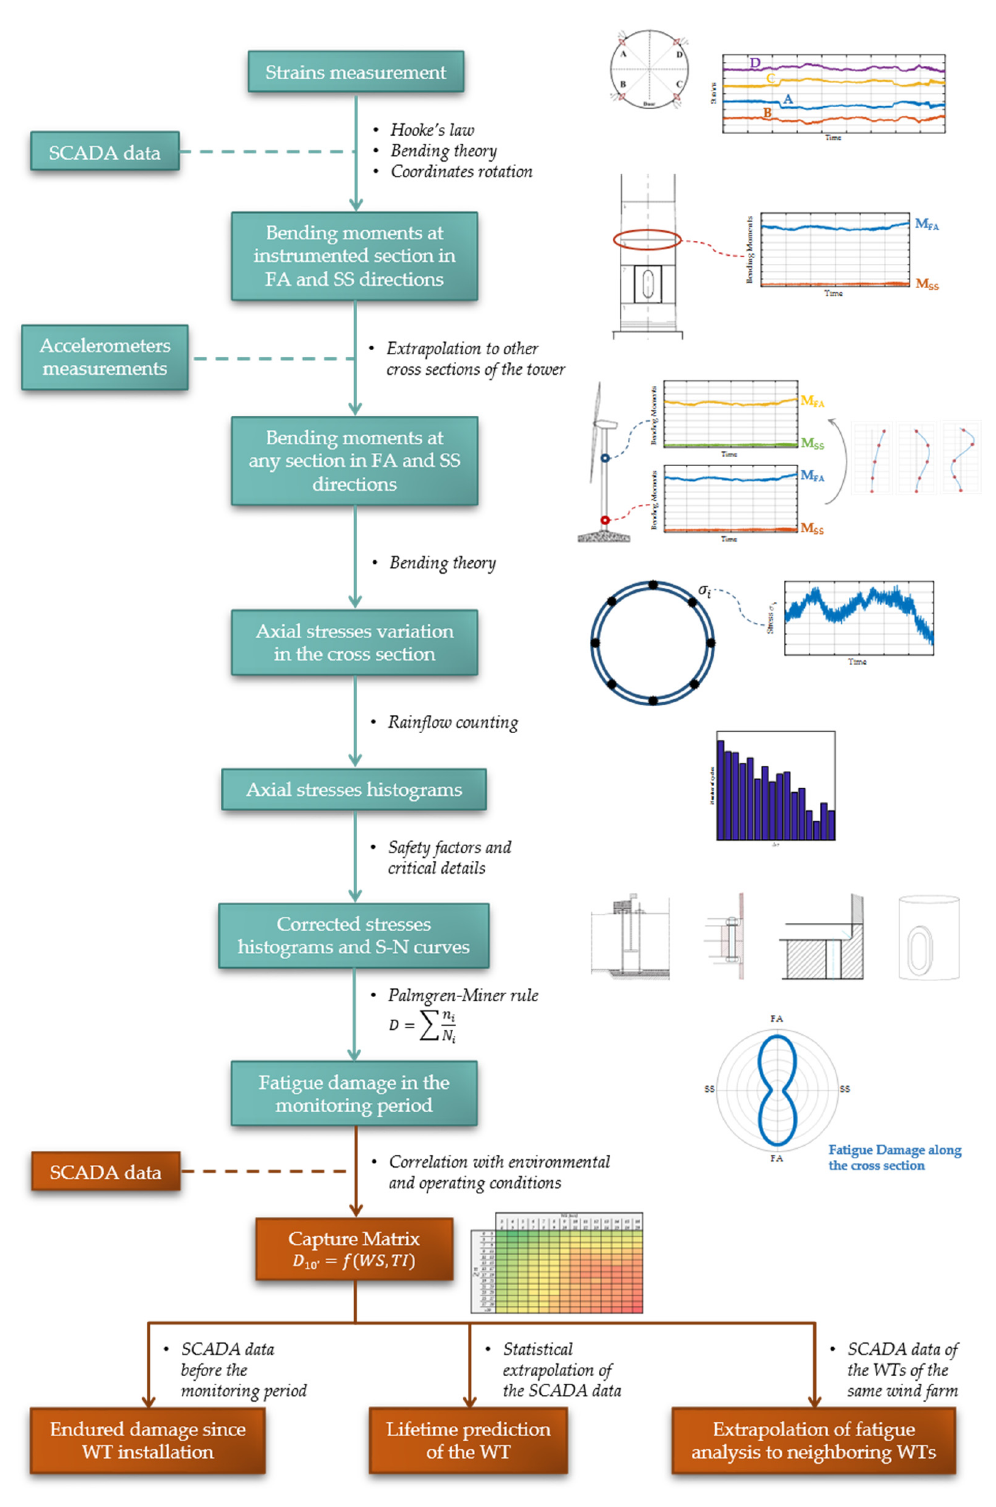
Figure 1. Fatigue assessment procedure based on strain measurements.